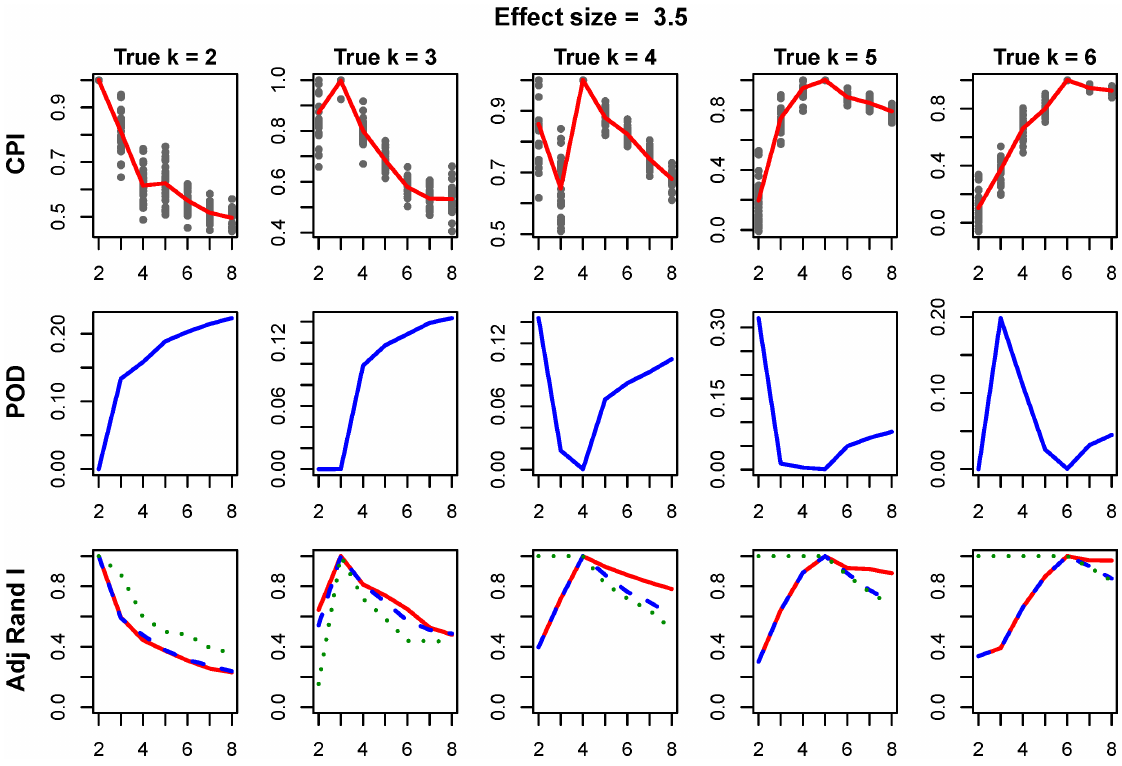
Fig 2. Comparison of intNMF and iCluster over varying k. First row represents the cluster prediction index, second row represents the plot of proportionof deviance(POD) given by iCluster method and third row represents adjustedrand index between(i) true and intNMF-clusters (red), (ii) true and iCluster-clusters (blue) and (iii) intNMF-clusters and iCluster-clusters (green). The POD is expectedto result in minimum at true numberof clusters. In other plots, maximum is expectedat true number of